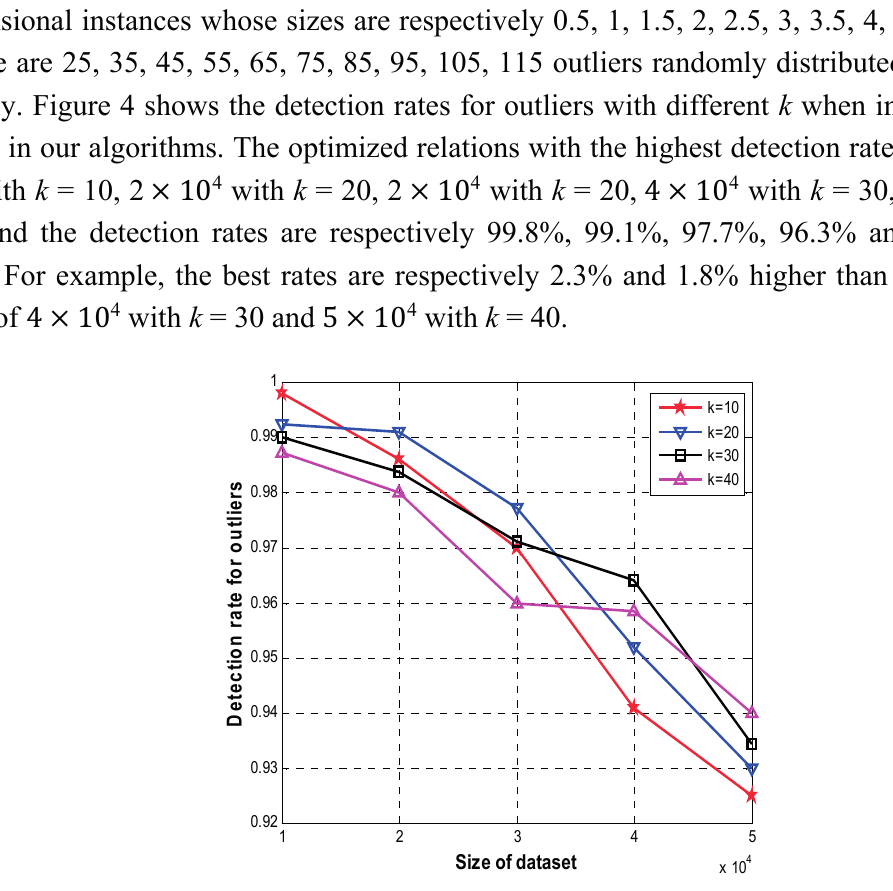
Figure 4. Detection rate for outliers with different k